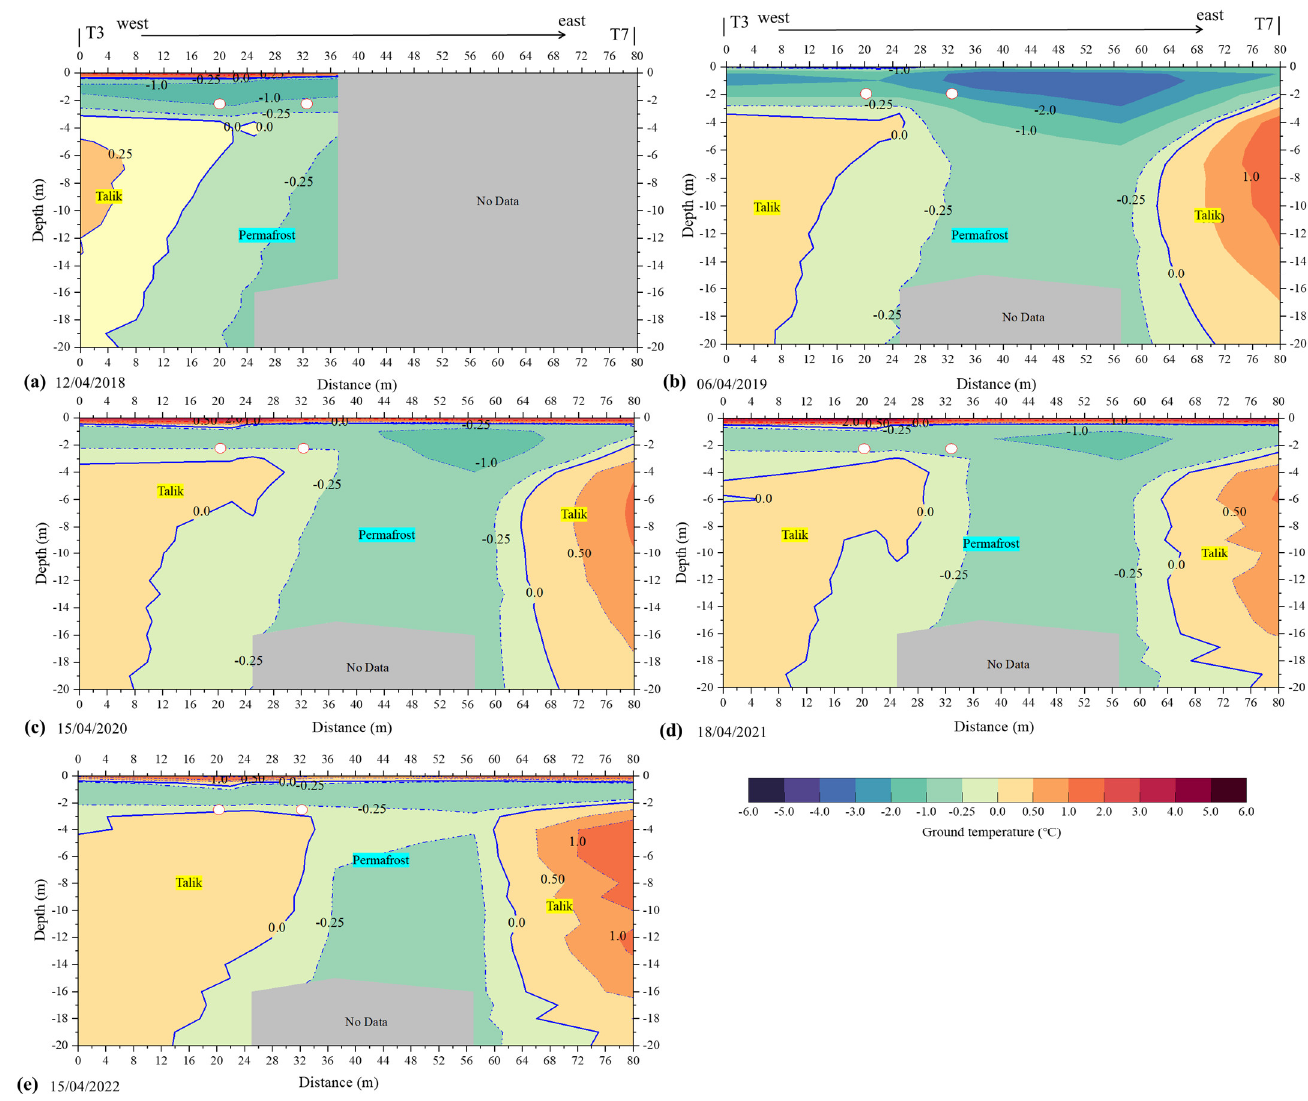
Figure 12. The cross-sectional isotherm profiles of the MDS304 site were drawn using the inverse distance weighting method from mid-April 2018 to mid-April 2022, including the ERT exploration period: ( a ) 12 April 2018, ( b ) 6 April 2019 ( c ) 15 April 2020 ( d ) 18 April 2021 and ( e ) 15 April 2022. Note: T3, T7 is a ground temperature borehole. The red circle represents the oil pipeline, and CRCOP-II and CRCOP-I are distributed sequentially from west to east.